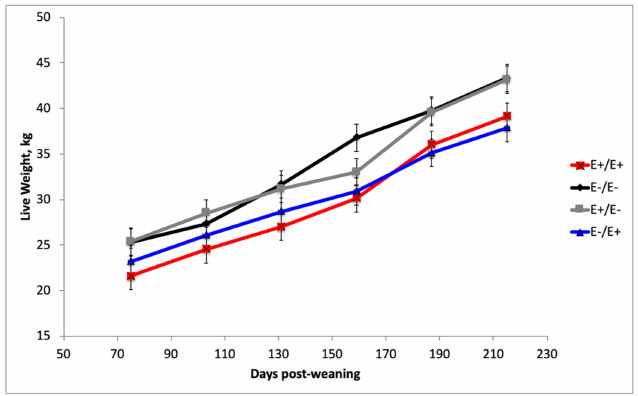
Figure 1. Live weight during post-weaning growth of ewe lambs born to ewes fed endophyte-free (E − ) or endophyte-infected (E + ) tall fescue seed during MID (d35 to 85) and / or LATE (d 85 to parturition) gestation. Table 1. Post-weaning growth rates in ewe lambs born to ewes fed endophyte-infected (E + )